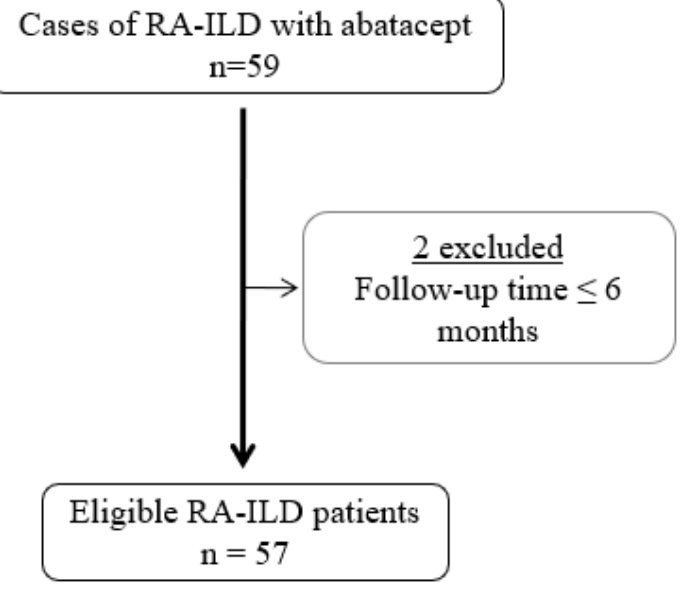
Figure 1. Patient flowchart. Table 1. Baseline characteristics of 57 patients with RA-ILD treated with abatacept.